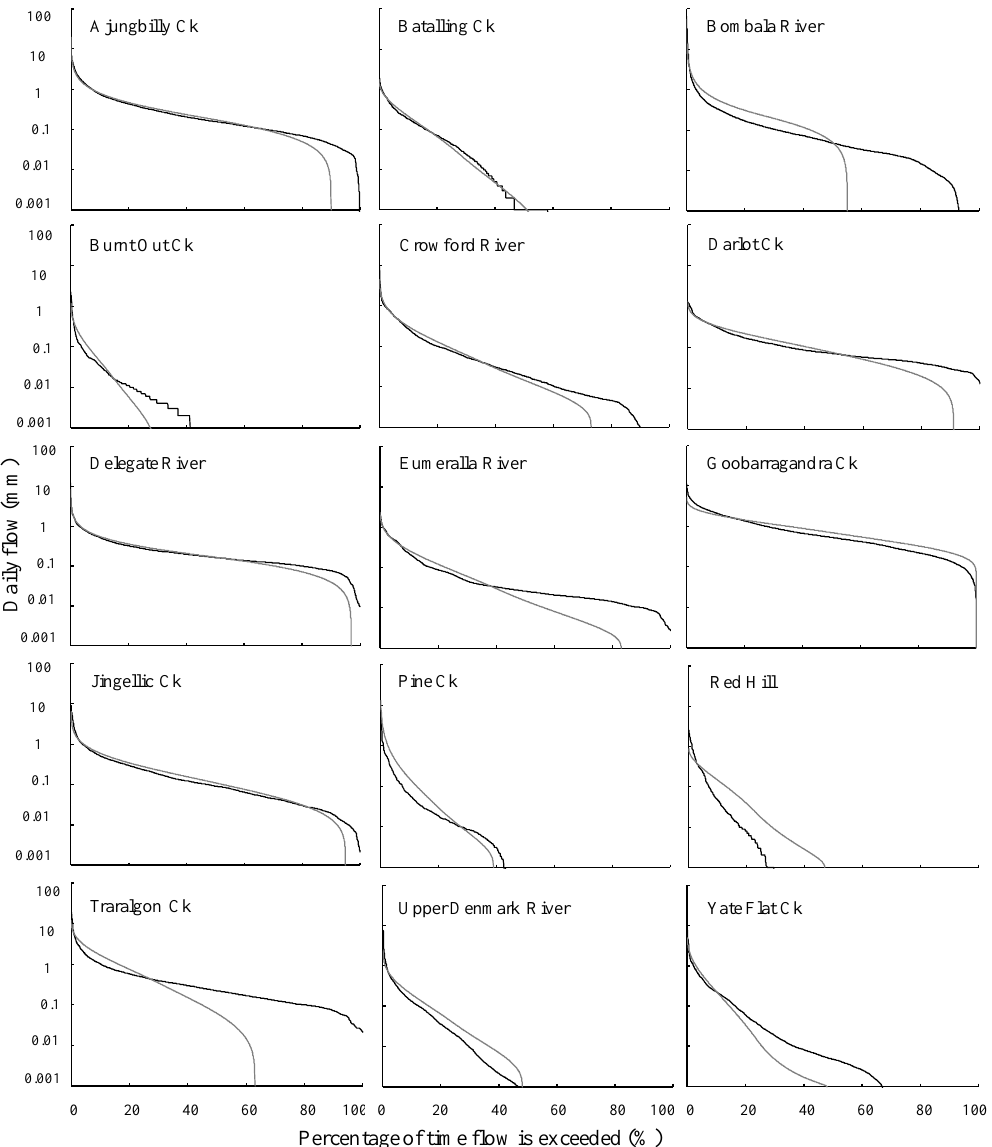
Fig. 7. Comparisons of FCFC predicted and observed flow duration curves for the selected catchments in the post-treatment period. The black lines represent observed flow duration curves, and the grey lines represent predicted flow duration curves.